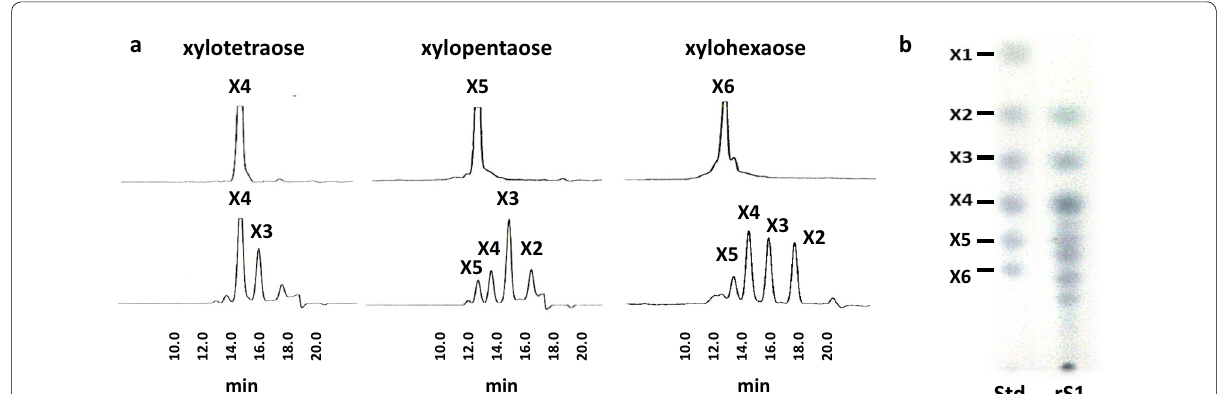
Fig. 3 End-product analysis of xylooligosaccharides and xylan hydrolyzed by rS1. The end products were analyzed by high-performance liquid chromatography ( a ). Thin-layer chromatography of hydrolysis products of soluble birchwood xylan ( b ). Authentic xylooligosaccharides were used as standards (lane Std). X1, xylose; X2 to X6, xylobiose to